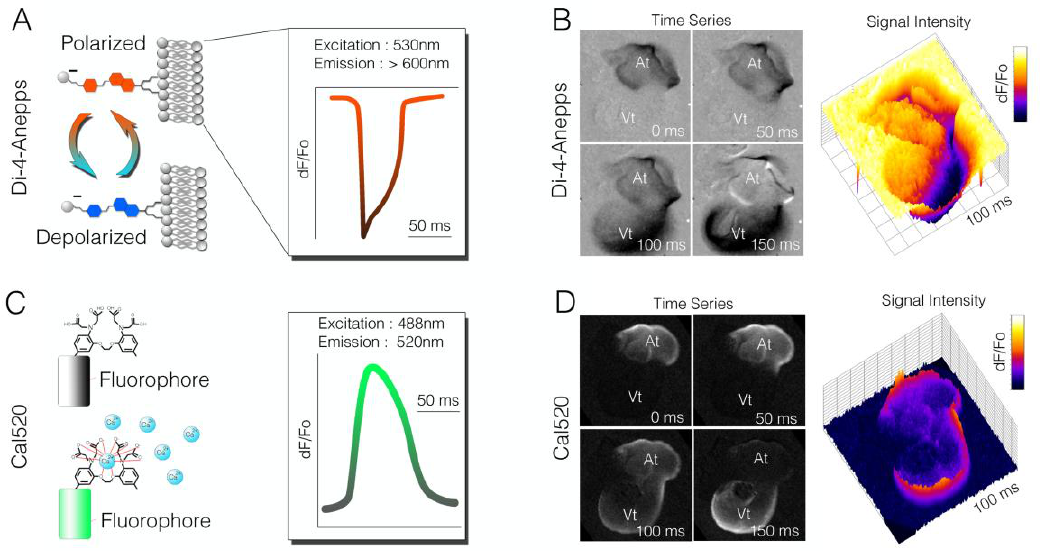
Figure 3. Comparison of voltage-sensitive dyes to small-molecule calcium indicators . ( A ) Diagram indicating change in spectral characteristics for the voltage-sensitive dye, Di-4-anepps. Depolarization causes a blue shift in the dye. In this example, an imaging system was designed to image long wavelengths (red), and a drop in fluorescence intensity correlated to an action potential being fired; ( B ) Time series of raw imaging data acquired from a Hamburger and Hamilton (HH) stage 18 chick heart stained with D-4-annepps. The drop in intensity was seen as the cardiac action potential propagated from atria to ventricle; ( C ) Diagram of the small-molecule calcium indicator Cal520. Calcium ion occupancy in the ETGA/BAPTA-like motif of the molecule increased fluorescence output, which could be imaged with most standard eGFP filter sets; ( D ) Raw imaging of Cal50 dF/Fo in a HH stage heart. Unlike Di-4-anepps ( B ), Cla520 increased its fluorescence signal upon depolarization.